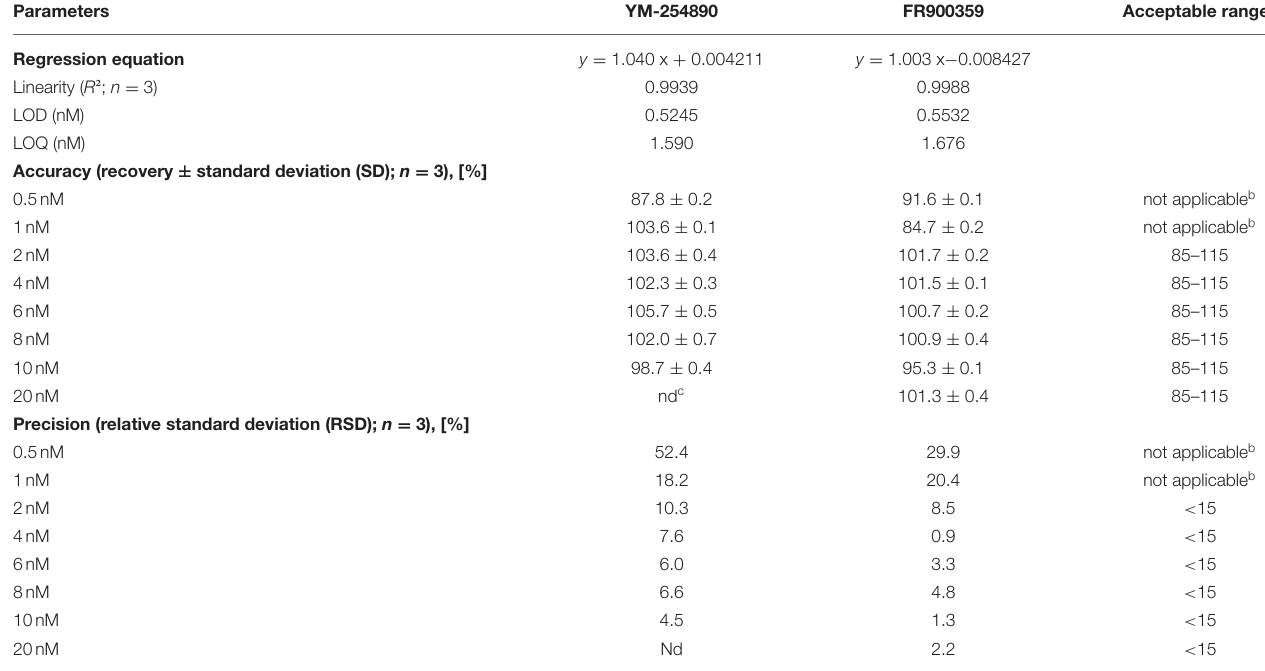
TABLE 1 | Validation of LC/MS-MS method for the quantitative analysis of FR and YM. Parameters Regression